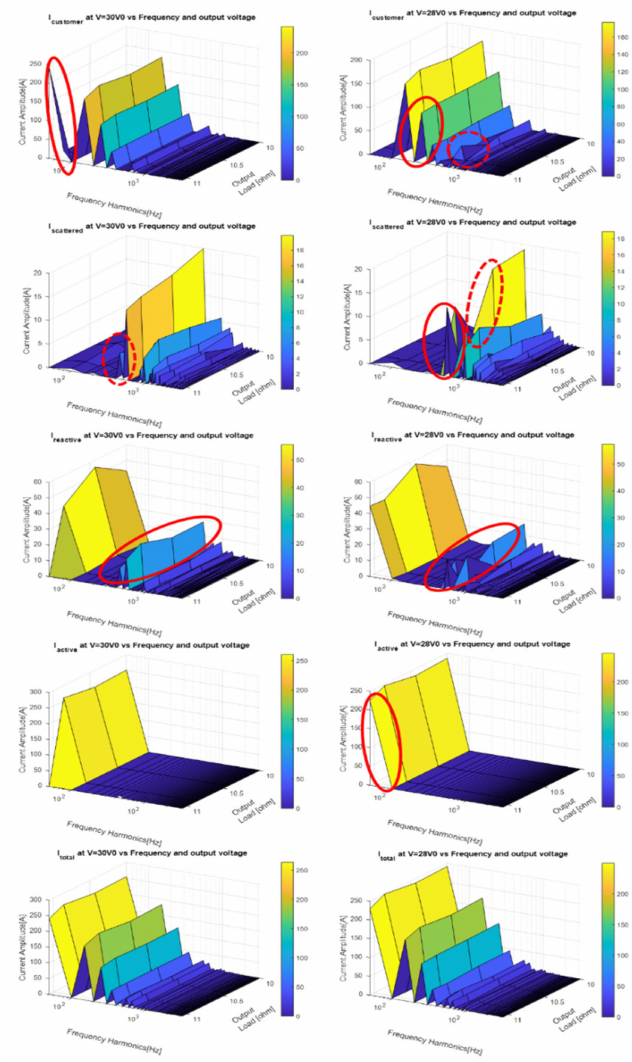
Figure 22. Loaded AC/DC converter 30 V vs. 28 V, variable load ( Ω ) total, active, scattered, reactive current. Differences are marked with red ellipses (currents are not normalized). Only amplitude graphs are